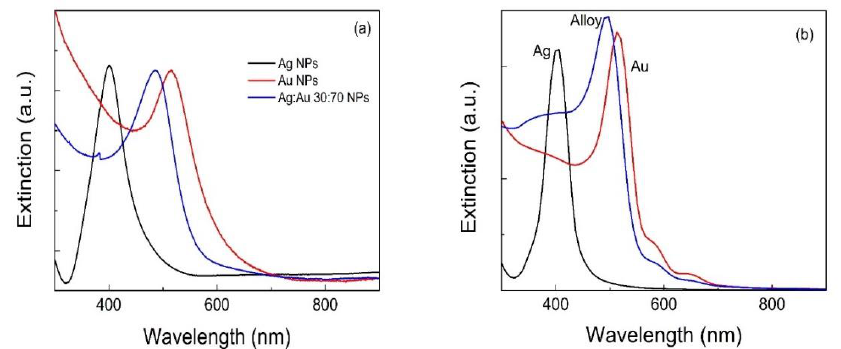
Figure 14. Absorption spectra of Ag, Ag:Au and Ag NP colloids produced from: ( a ) laser ablation in liquids of Ag, Ag:Au alloy and Au targets, respectively; ( b ) a Boundary Element Method (BEM) simulation.